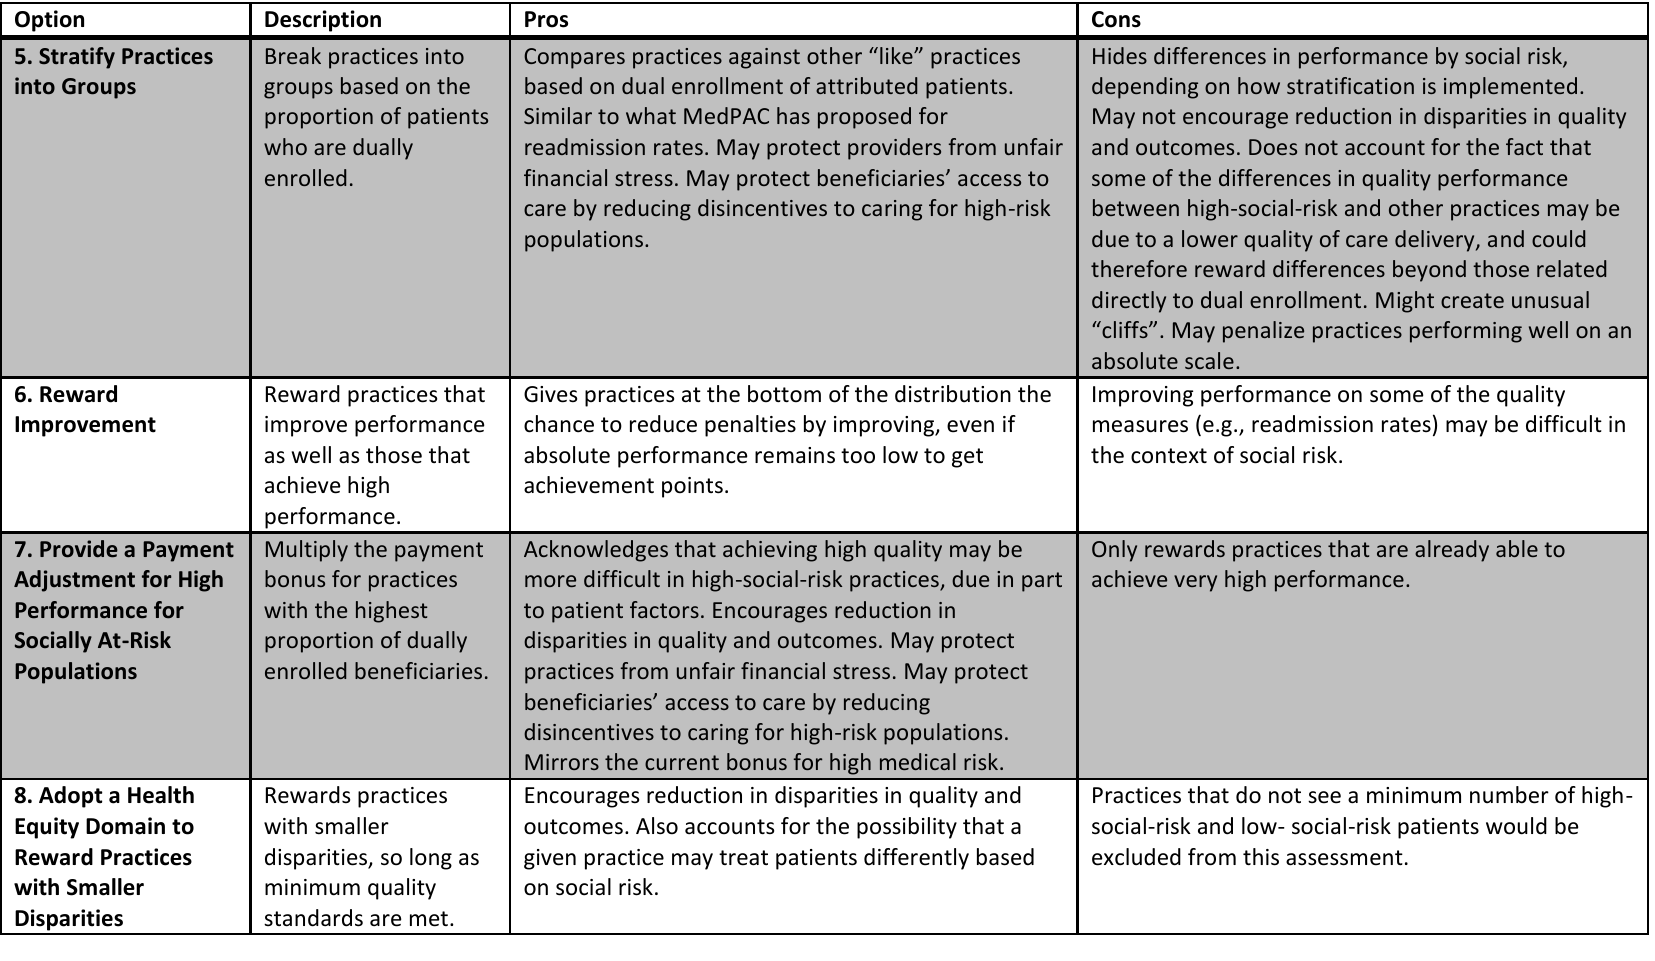
Table 10.16 (continued). Summary of Policy